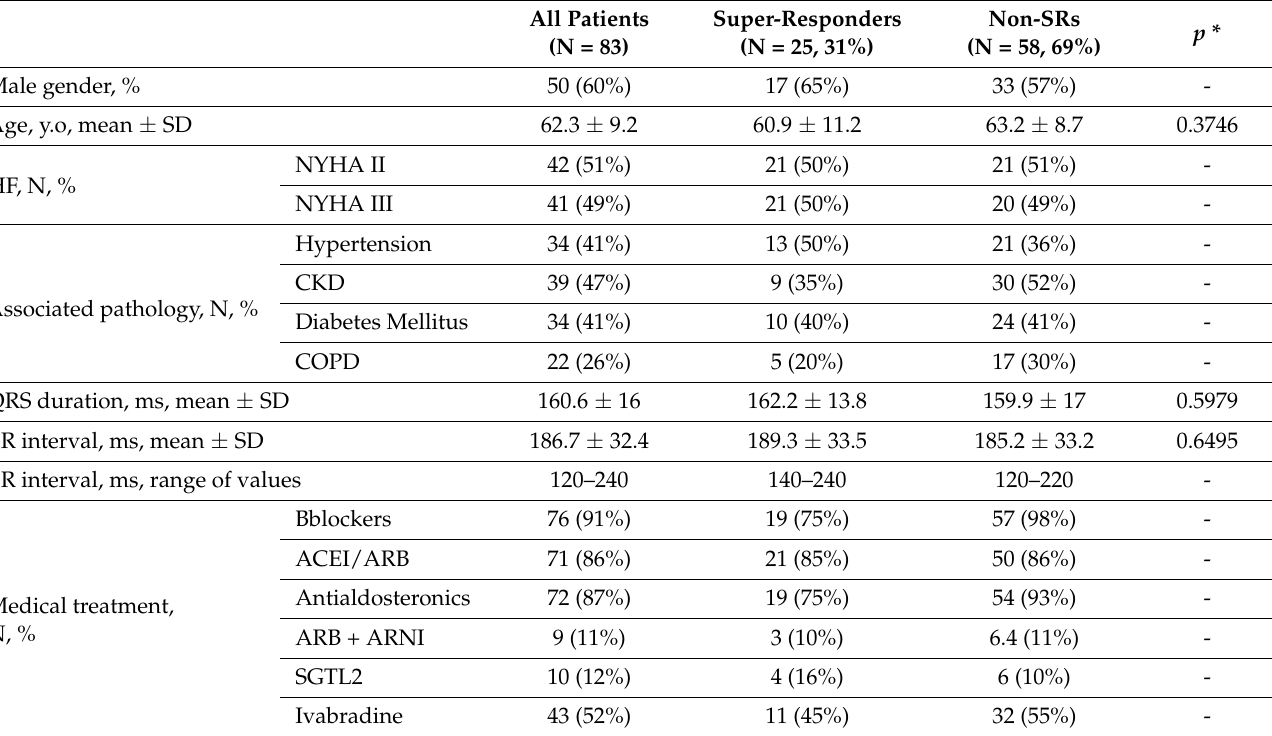
Table 1. The main demographic parameters and medical treatments in all patients and groups of SRs and